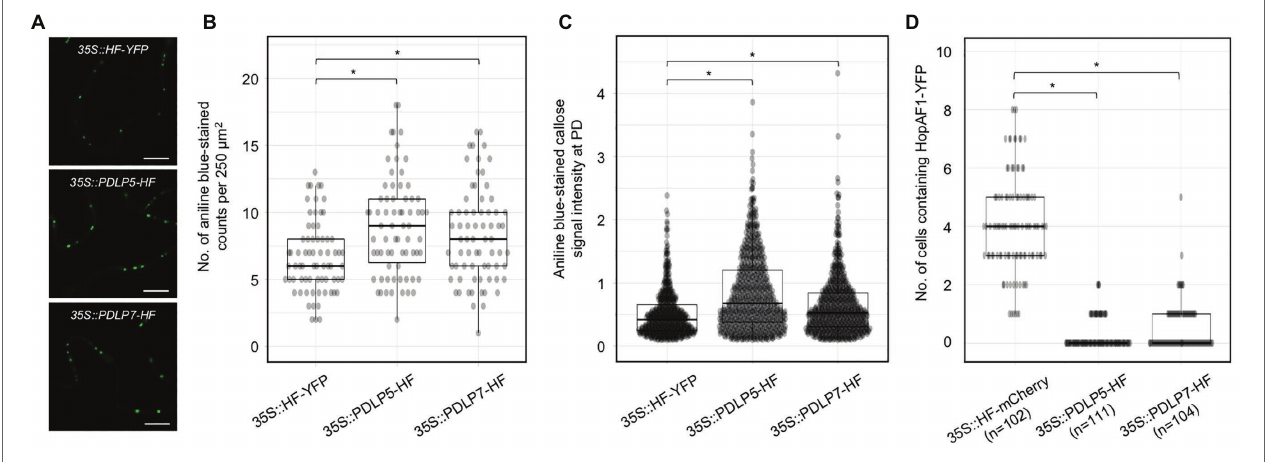
FIGURE 3 | Expression of PDLP5 and PDLP7 suppresses the PD-dependent movement of HopAF1. (A) Expression of plasmodesmata-located proteins (PDLPs) affects callose accumulation at PD. N. benthamiana leaves were infiltrated with Agrobacteria harboring 35S::HF-YFP , 35S::PDLP5-HF , and 35S::PDLP7-HF . Infiltrated leaves were stained with 0.01% aniline blue and imaged with confocal microscopy. Scale bars = 10 μ m. (B) Quantitative data present the number of aniline blue-stained callose at PD per 250 μ m 2 of N. benthamiana epidermis. Mann-Whitney U Test was used to analyze the data. The p -value is <0.05 (*). (C) Quantitative data present the accumulation of callose at PD. Mann-Whitney U Test was used to analyze the data. The p -value is <0.0001 (*). (D) Quantitative data present the PD-dependent movement of HopAF1-YFP when co-expressed with 35S::HF-mCherry , 35S::PDLP5-HF , and 35S::PDLP7-HF . Mann-Whitney U Test was used to analyze the data. The p -value is <0.00001 for both 35S::PDLP5-HF and 35S::PDLP7-HF (*). The number of transformation events analyzed is indicated ( n